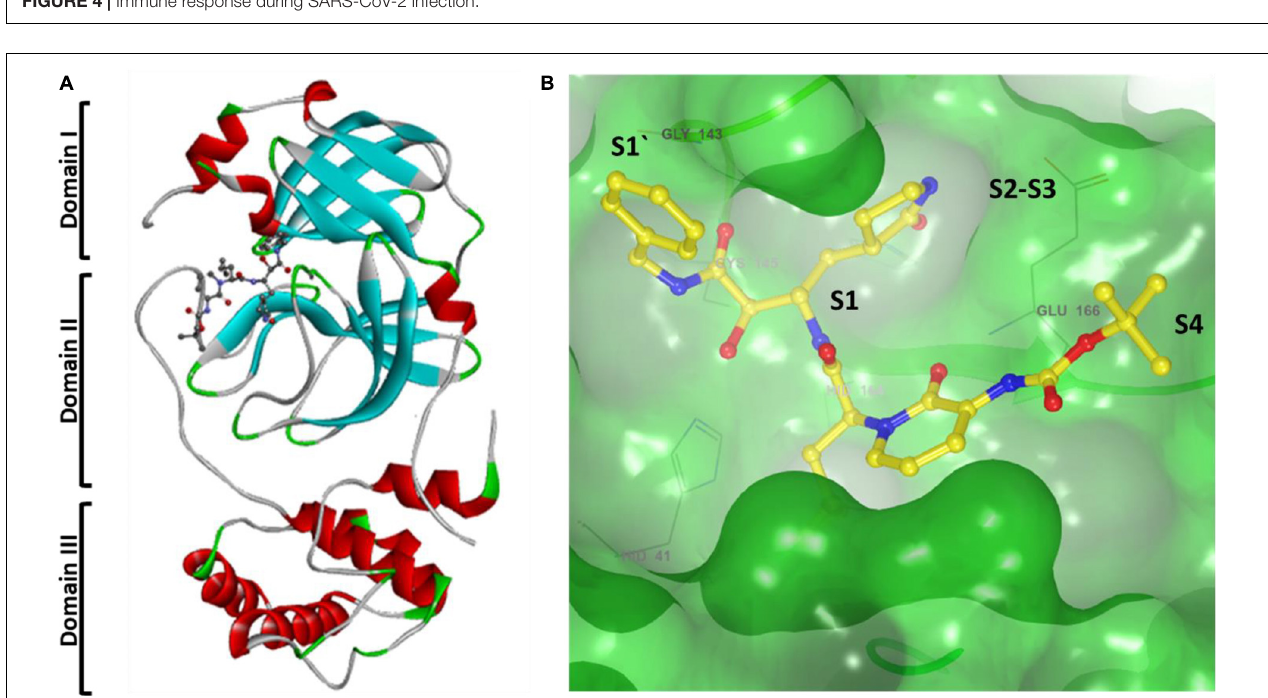
FIGURE 5 | (A) Cartoon representation of one protomer of the dimeric M pro –inhibitor complex. (B) Surface presentation of conserved substrate-binding pockets of M pro from coronaviruses. The key residues that form the binding pocket are shown in sticks, conserved substitution in M pro of more than one of the coronaviruses. S1, S2, S4, and S1 (cid:48) subsites are